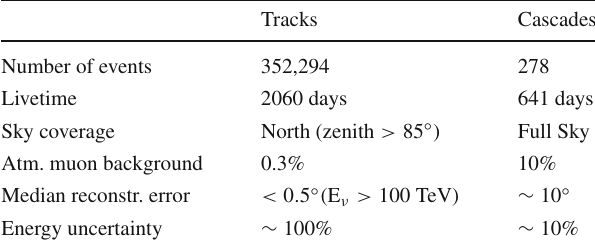
Table 1 Summary of the two event samples. Detailed sample descrip- tions can be found in Refs. [2,51]